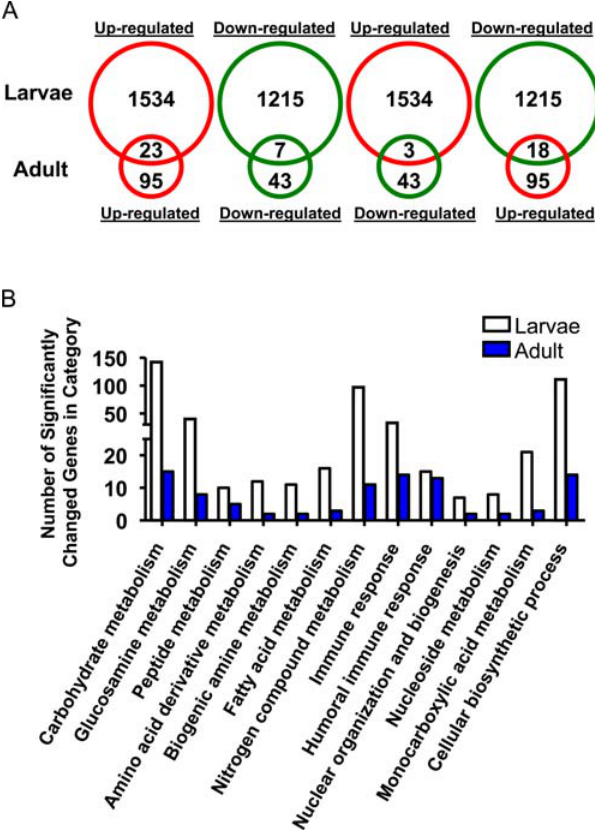
Figure 2. Gene expression profiles in hypoxia-selected Dro- sophilamelanogaster in larvae and adult flies. A) Comparison of gene expression alterations in hypoxia-selected Drosophila melanoga- ster in the larva and adult fly. Expression levels of 2749 genes (1534 up- and 1215 down-regulated) in larvae and 138 genes (95 up- and 43 down-regulated) in the adult were significantly altered in AF (fold change . 1.5 and q , 0.05). Red: up-regulation; Green: down-regulation. B) Summary of significantly altered biological processes in larvae and adult hypoxia-selected Drosophila melanogaster (p , 0.05).